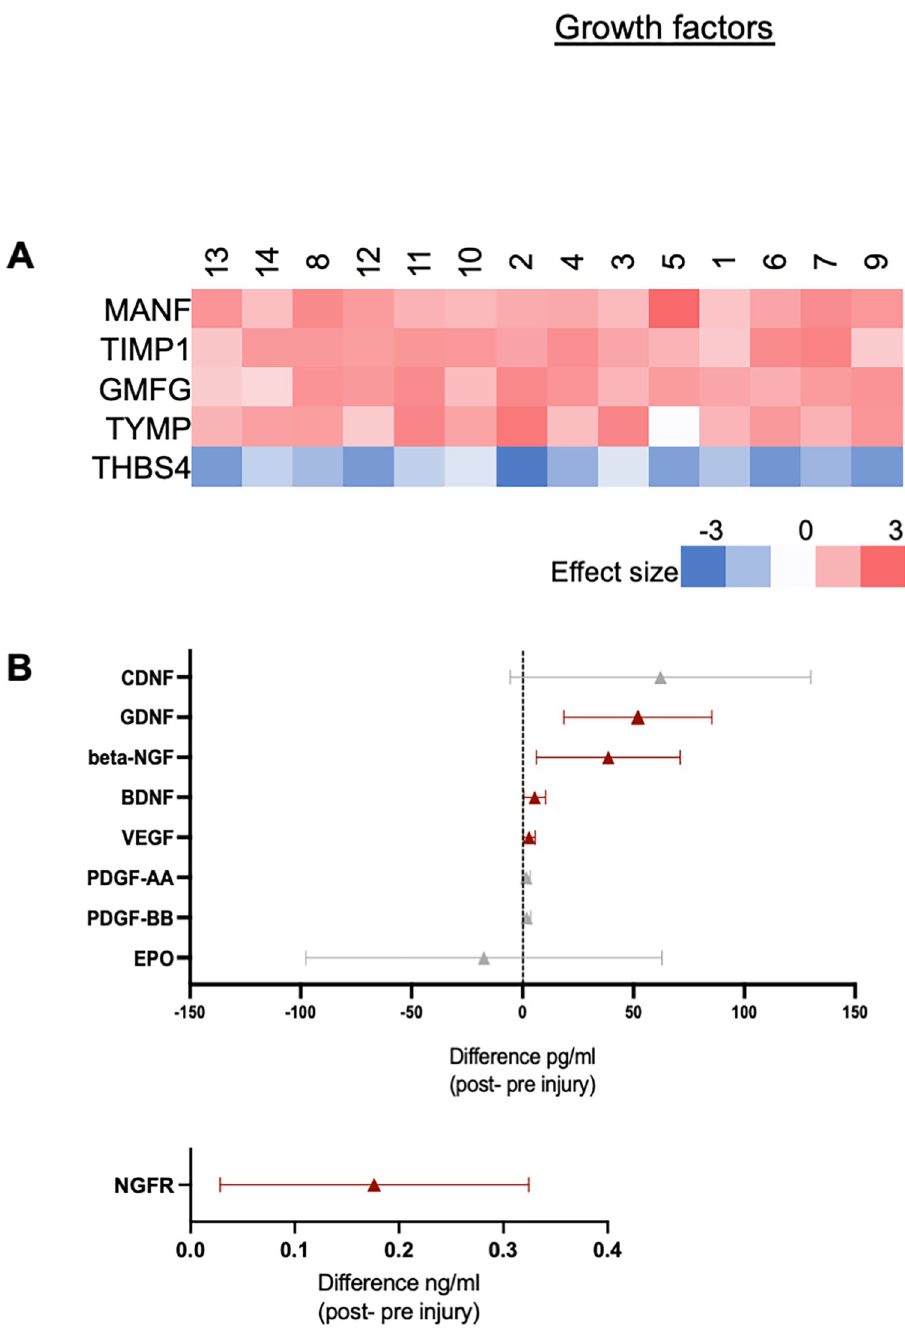
Fig 5. Changes in growth factors after injury based on the GO pathway “Growth Factor Activity”. A. Mass Spectrometry: Analysis of all the protein products that were significantly upregulated or downregulated (q- value � 0.05 and Z � |2|, range: -3 to 3). B. Immunoassay: Mean (triangle) differences, between na ï ve and injured tissue samples, and 95% CI for EPO, PDGF-AA and–BB, VEGF, BDNF, NGFR, beta-NGF, CDNF, and GDNF. Red markers represent mean difference CIs that were above zero and gray ones represent mean difference CIs that include